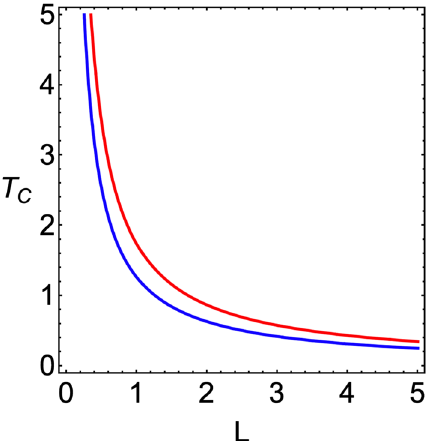
Fig. 12 T F c (blue line) and T P c (red line) as functions of the distance between plates